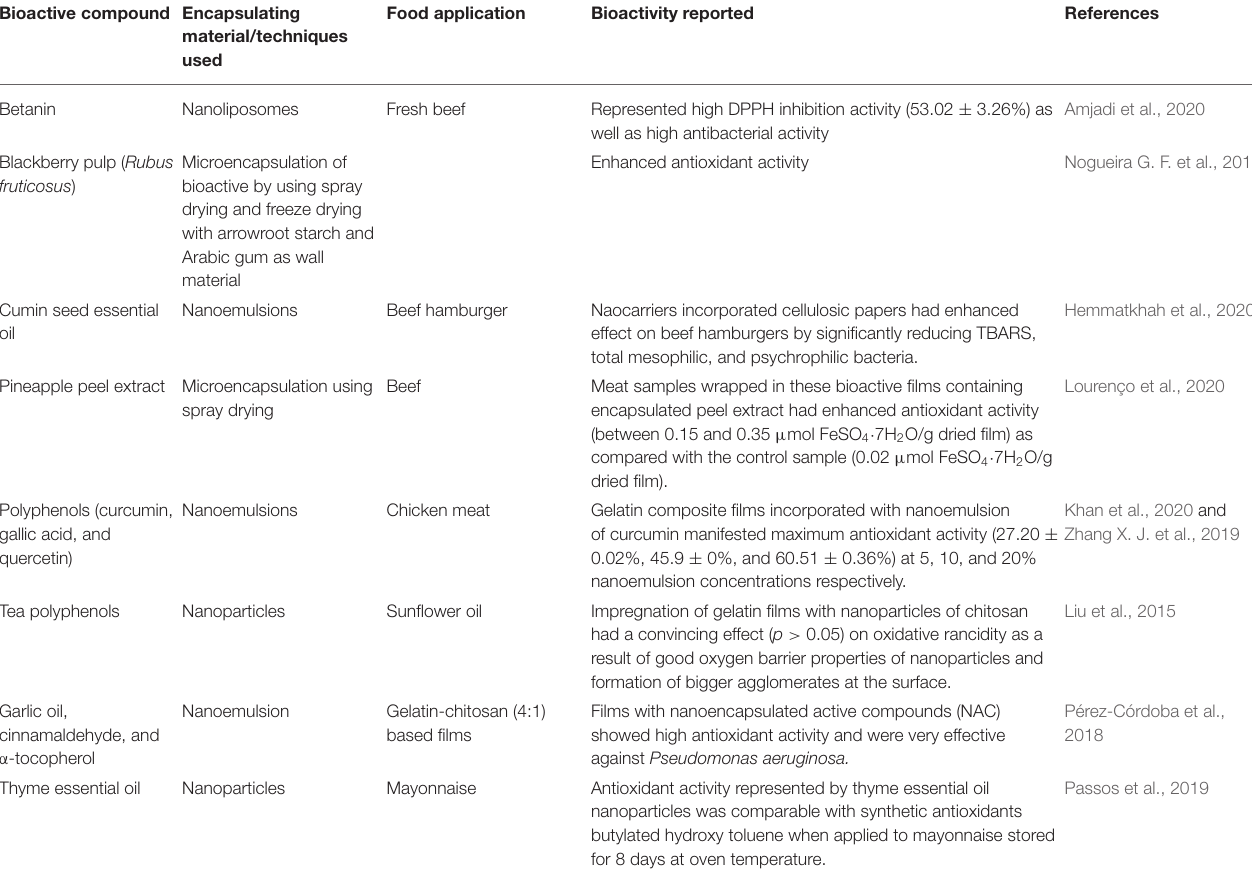
TABLE 3 | Research findings related to the effect of encapsulated antioxidants in edible packaging on oxidative stability of food